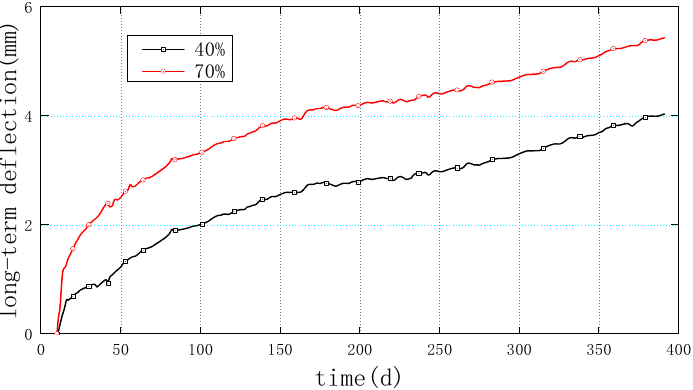
Figure 17. Evolution of the long ‐ term deflection of concrete T ‐ beam specimens for two load levels (loading age of 14 days).